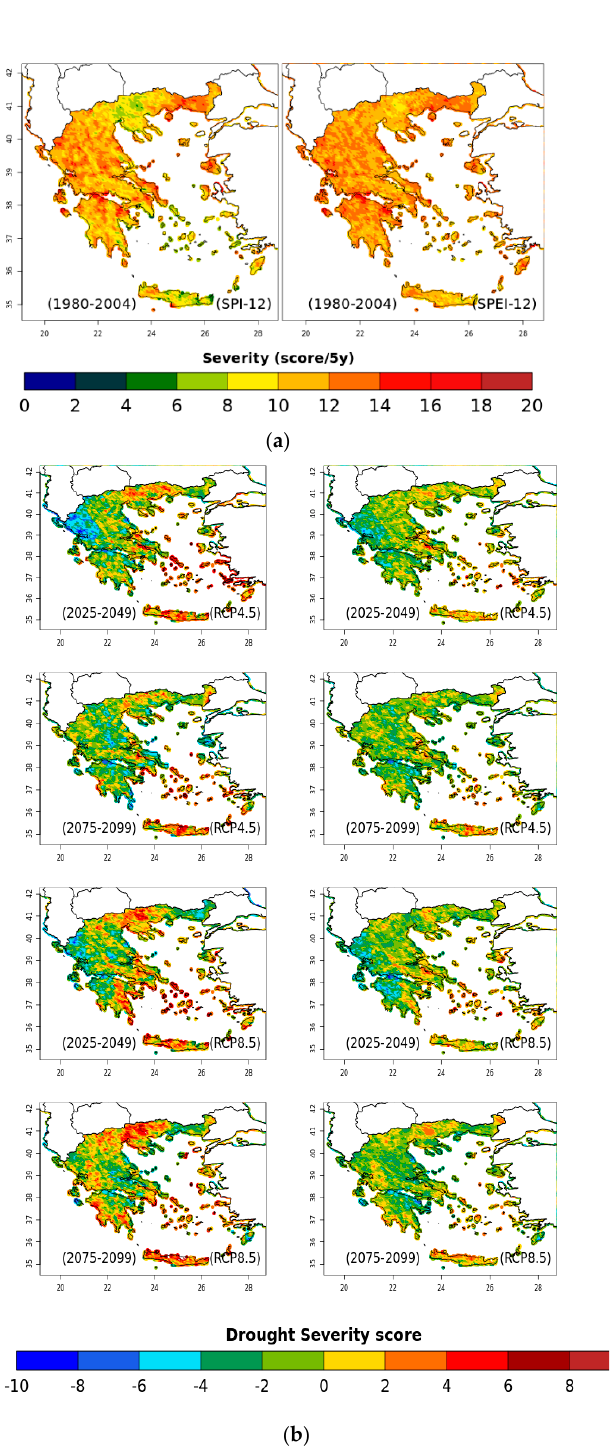
Figure 12. ( a ) Drought severity as the number of events in 25 years for the reference period (1980–2004) for the SPI and the SPEI indices computed at a 12-month timescale. ( b ) Changes in the duration for the 12-month SPI and SPEI for the near future period (2025–2049) and the far future (2075–2099) relative to the reference period (1980–2004) under RCP4.5 and RCP8.5. Similar patterns are observed regarding the spatial trends of corresponding drought characteristics derived from the 12-months SPI and SPEI, as presented in Figures 14 and 15 respectively; however, the results obtained with SPI show higher positive trends. Re- garding the far future, the two scenarios show different tendencies of projected drought conditions, with larger areas of strong positive trends under RCP8.5. In particular, the projections with both indices reveal longer and more intense and severe drought events under RCP8.5. However, the results indicate, with spatially limited statistical significance, an amplified signal for Crete with less intense and severe droughts of shorter duration, in the near future and under RCP8.5.